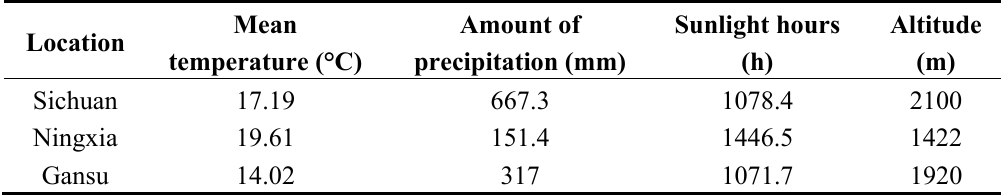
Table 6. Environment parameters during the whole growing period at 3 tartary buckwheat growing locations in